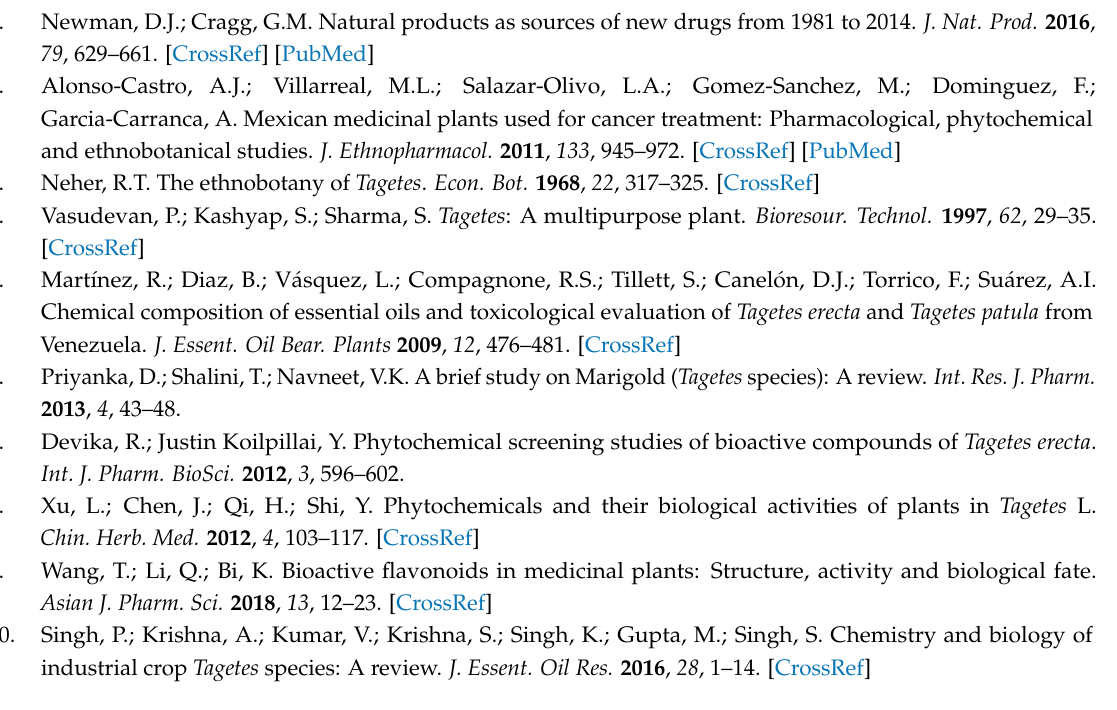
Figure S2: 13 C-NMR spectrum of quercetagetin ( 2 ), Figure S3: HSQC spectrum of quercetagetin ( 2 ), Figure S4: HMBC spectrum of quercetagetin ( 2 ), Figure S5: HR-DART-MS positive ion mode spectrum of patuletin ( 3 ), Figure S6: HR-DART-MS positive ion mode spectrum of quercetagetin ( 2 ), Figure S7: Detection of active